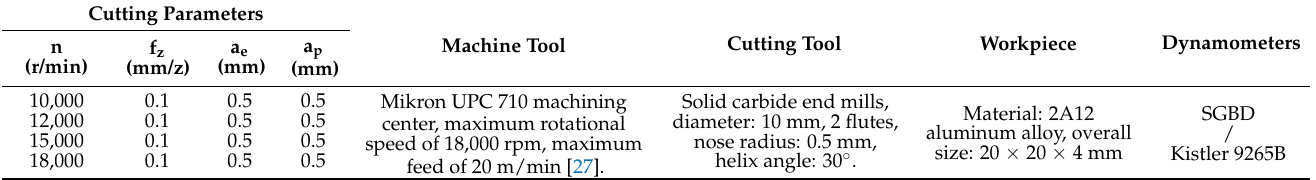
Figure 8. Principle of cutting force measurement. Table 3. The experiment setup.